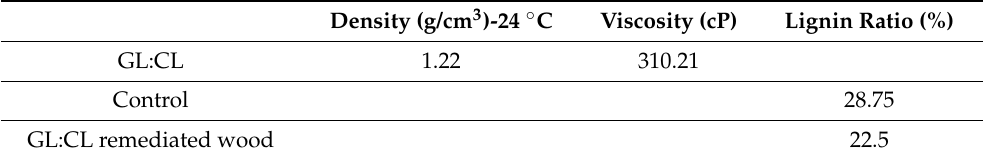
Table 1. Density (g/cm 3 )-24 ◦ C, Viscosity (cP), and Lignin ratio (%) values of the samples.